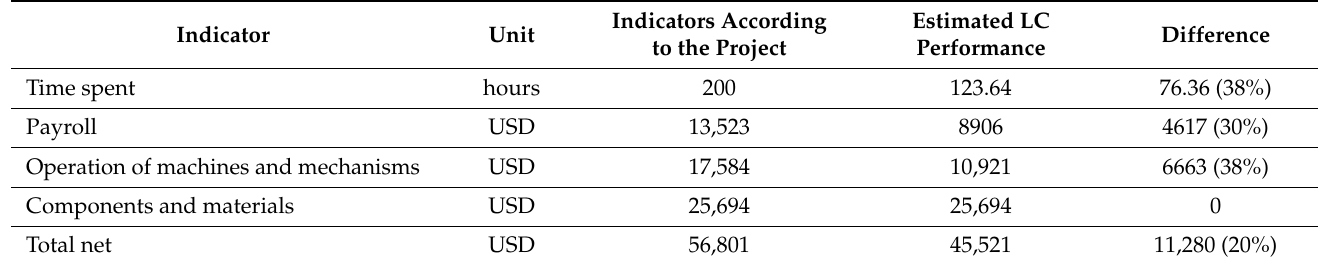
Table 5. Calculated indicators before and after methodology